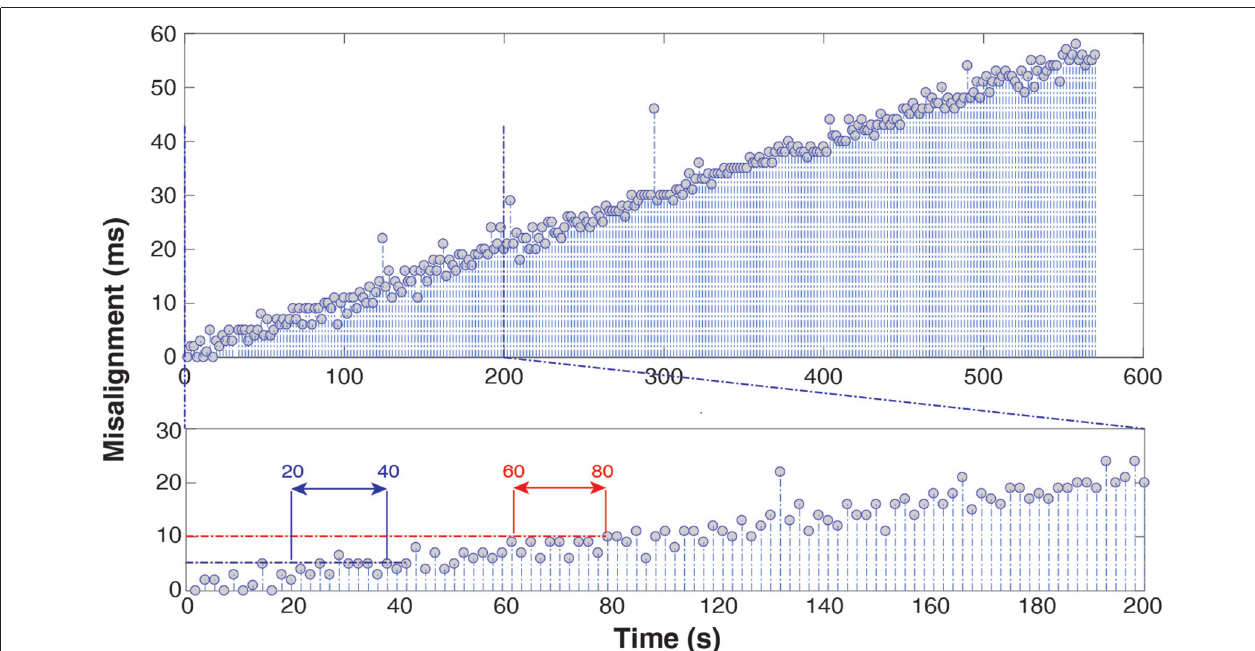
FIGURE 6 | Spike misalignment trend throughout the whole recording (top) and over the first 200 s (bottom) after alignment of EMG relying on manufacturer-declared sampling frequency. It takes only 1 min to accumulate a 10 ms